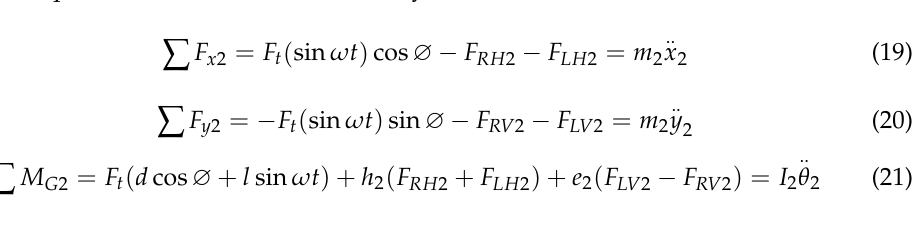
Figure 6. The free body diagram under the cyclic wind force with a specific frequency. The equation of motion for the car body: